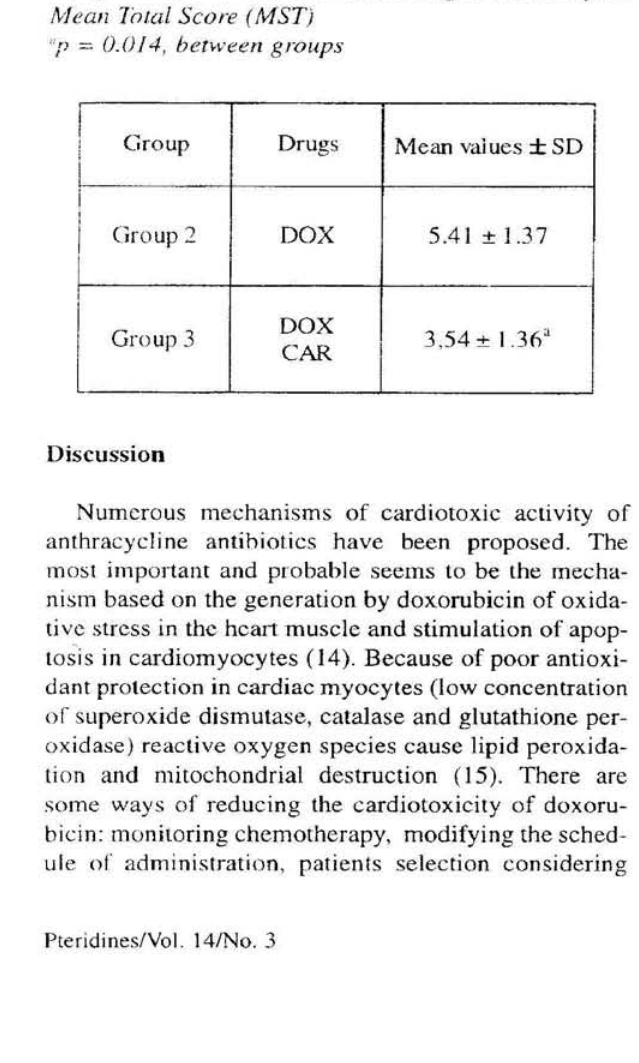
Pteridines/Vol. 14/No.